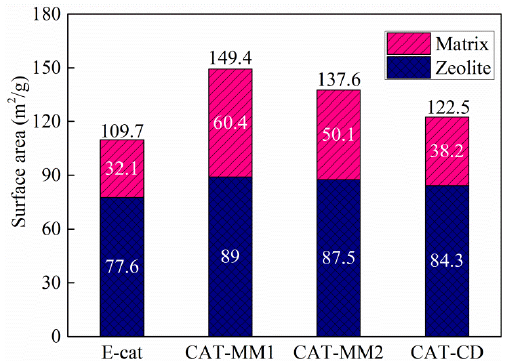
Figure 5. Zeolite, matrix, and total surface areas of the different catalysts.